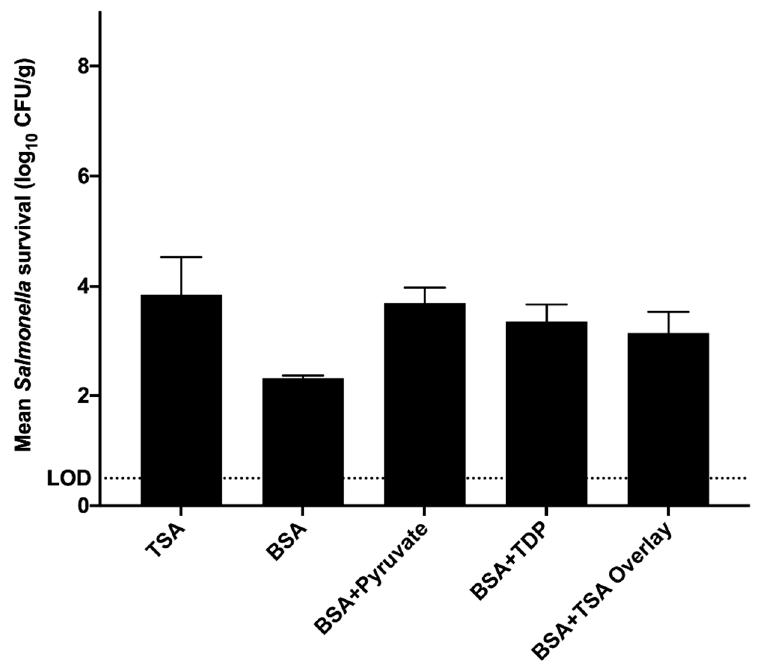
Figure 2. Mean numbers of survivors of Salmonella enterica recovered from whole chicken blood subjected to heating for 3.0 min at 93.3 ° C ( p = 0.130; pooled standard error = 0.565). Bars depict means from three identically completed replicates ( N = 3); error bars present one standard error. Salmonella cells were enumerated on tryptic soy agar (TSA), bismuth sulfite agar (BSA), BSA supplemented with 0.1% ( w/v ) sodium pyruvate (BSA ± Pyruvate), BSA supplemented with 0.1% ( w/v ) 3,3 ′ - thiodipropionic acid (BSA ± TDP), or BSA with TSA overlay. Salmonella colonies were enumerated after plates were incubated at 36 ± 1 ° C for 24–48 h.